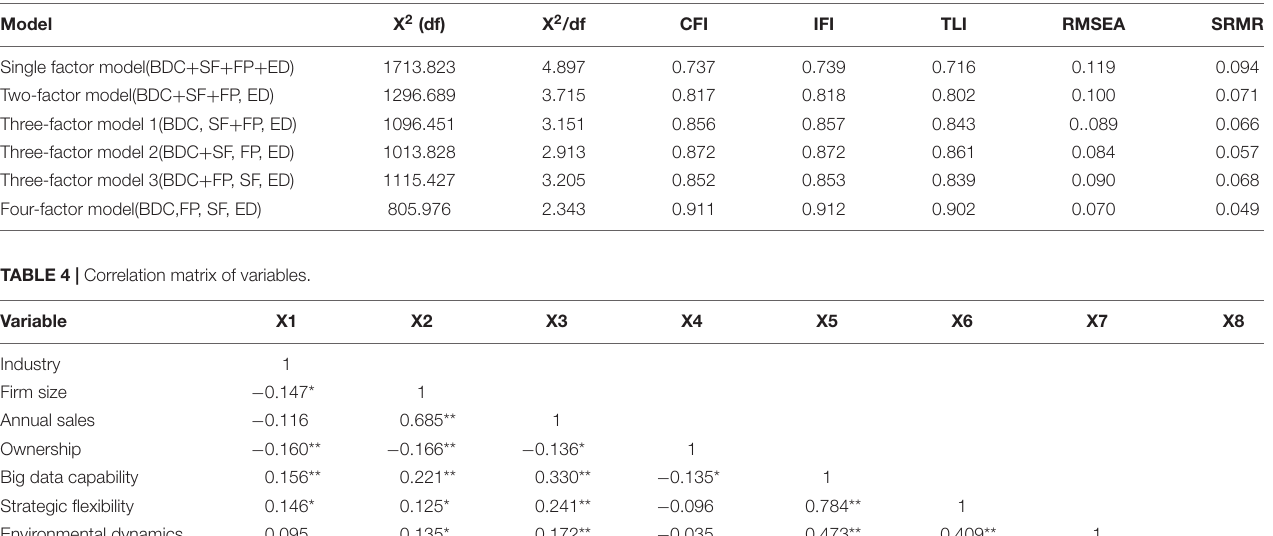
TABLE 3 | Analysis of confirmatory factors.